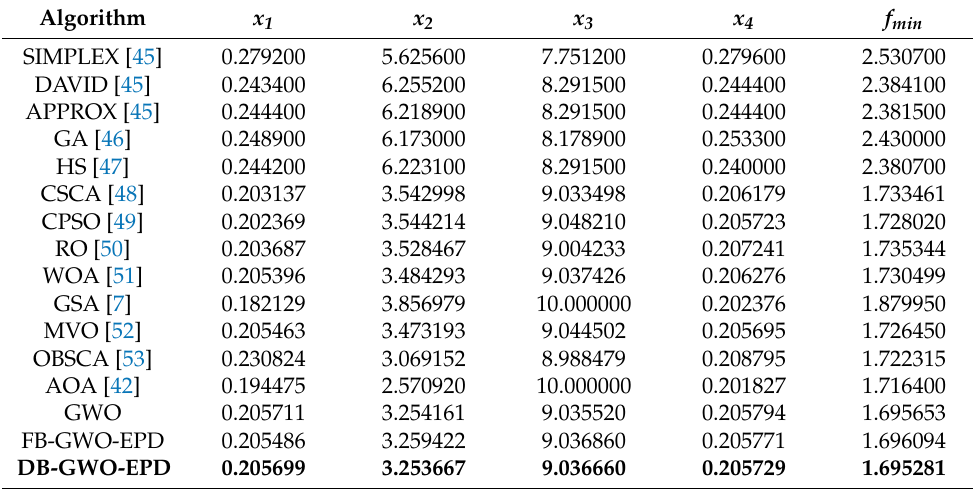
Table 9. Results of solving the welded beam design problem.